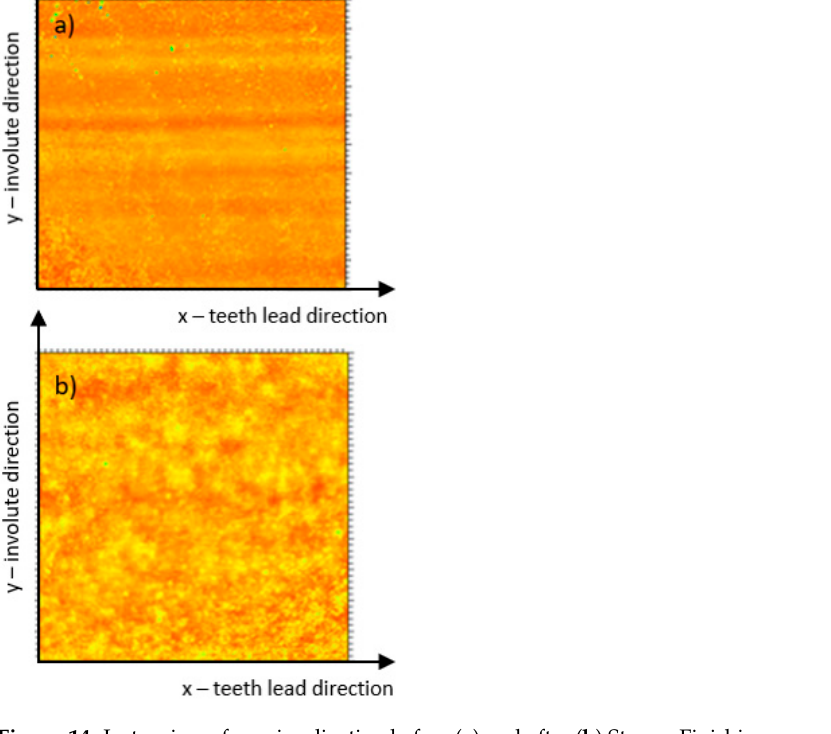
Figure 14. Isotropic surface visualization before ( a ) and after ( b ) Stream Finishing process optimi- zation.